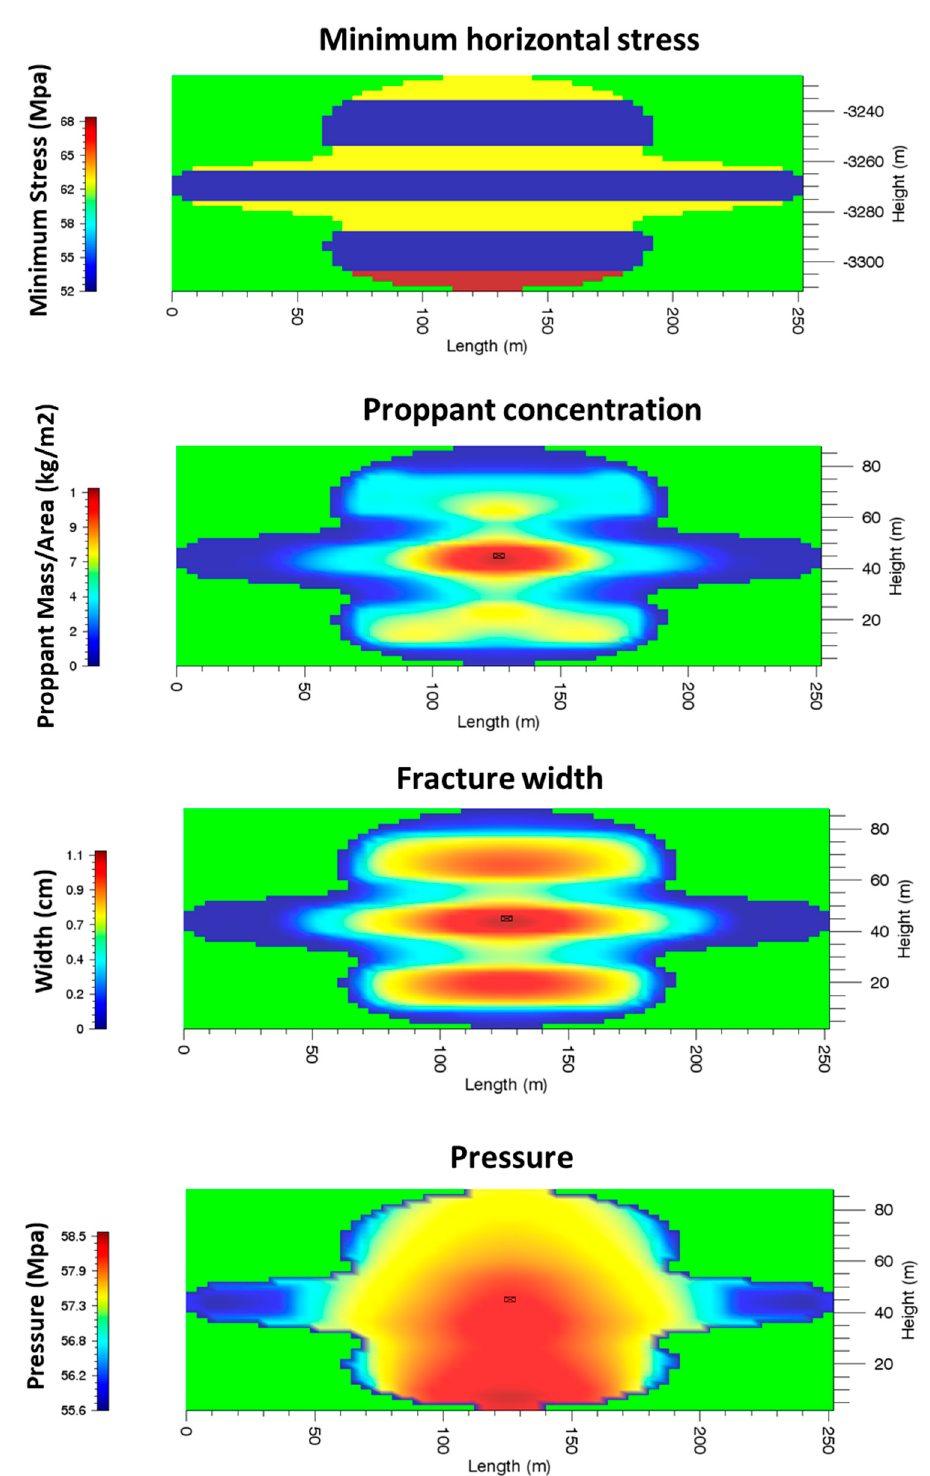
Figure 15. The stress profile, fracture width, proppant concentration and fluid pressure across the fracture of Case 4.